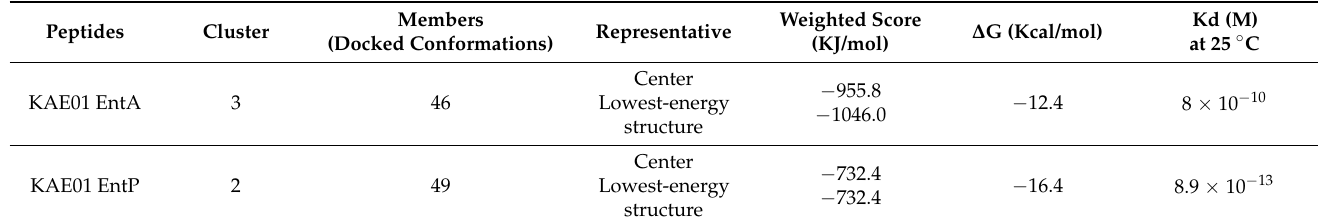
Table 5. Weighted scores, binding affinity ( ∆ G), and dissociation constant (Kd) of the interaction of each peptide with the matrix protein of P. aeruginosa